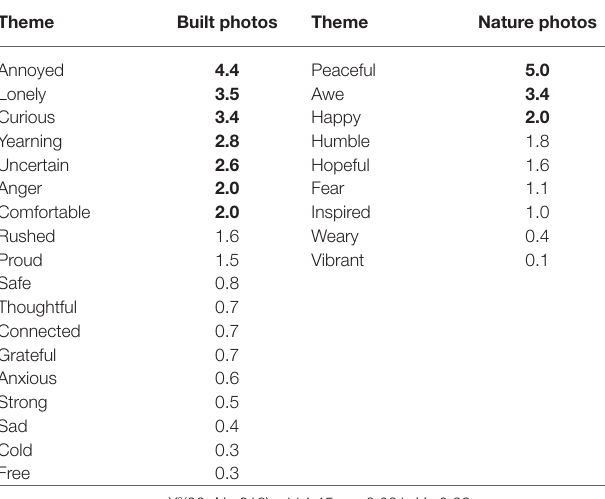
TABLE 6 | Chi-square analysis for emotion themes by photo-type. Adjusted standardized residuals indicating significance of positive association with photo-type